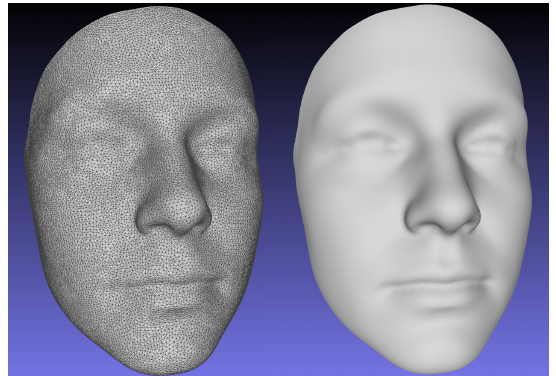
Figure 5. The averaged normative facial mesh used as the atlas for the Non-rigid Iterative Closest Point (NICP)